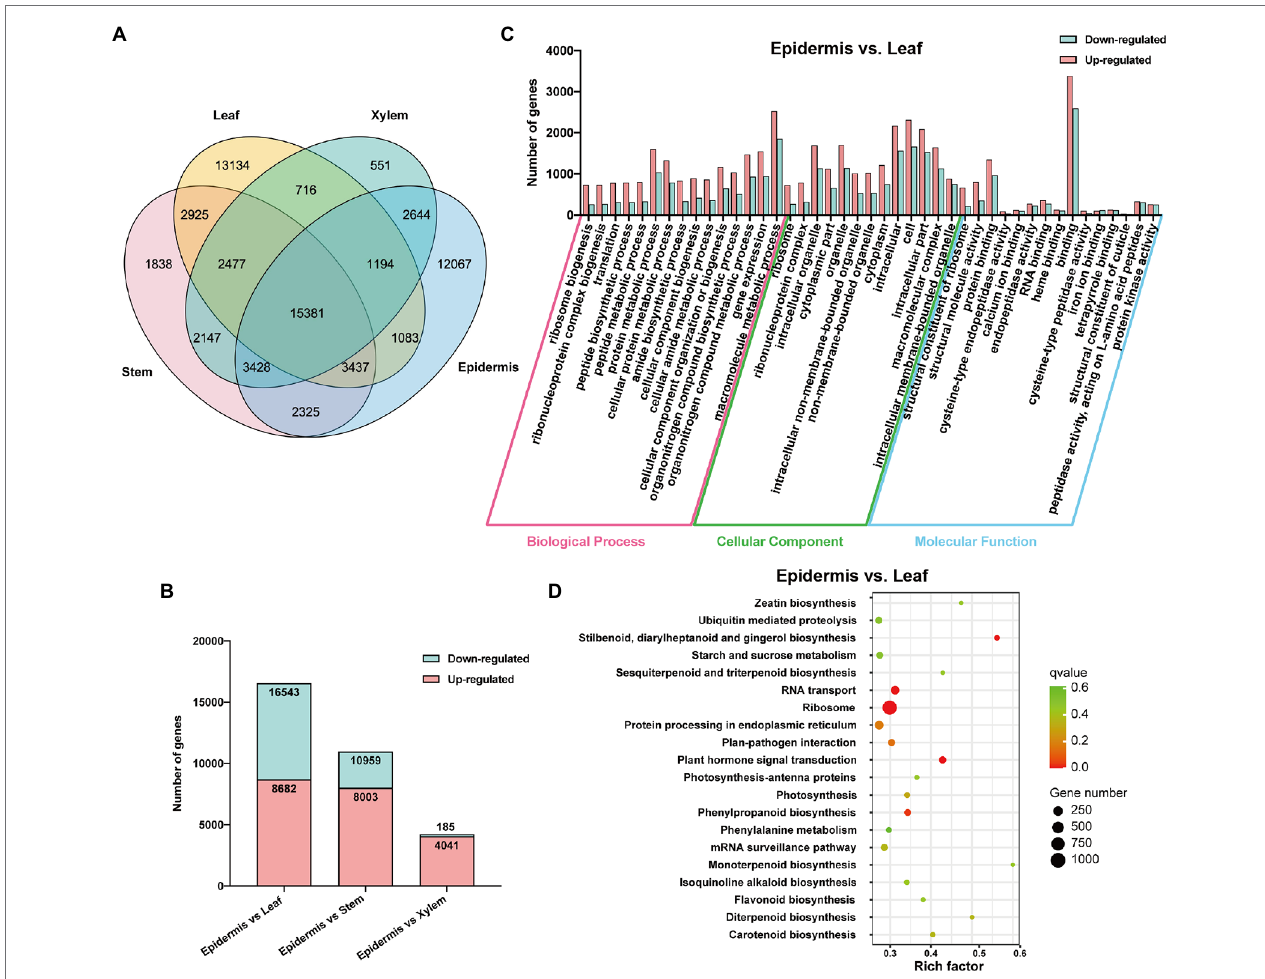
FIGURE 2 | Functional annotation of DEGs. (A) The distribution of unigenes in different tissues. (B) Differentially expressed unigenes profiling of three libraries of epidermis vs. leaf, epidermis vs. stem, and epidermis vs. xylem of Stephania tetrandra . (C) GO enrichment analysis of DEGs in epidermis vs. leaf. (D) Scatterplot of KEGG pathway enrichment of DEGs in epidermis vs.